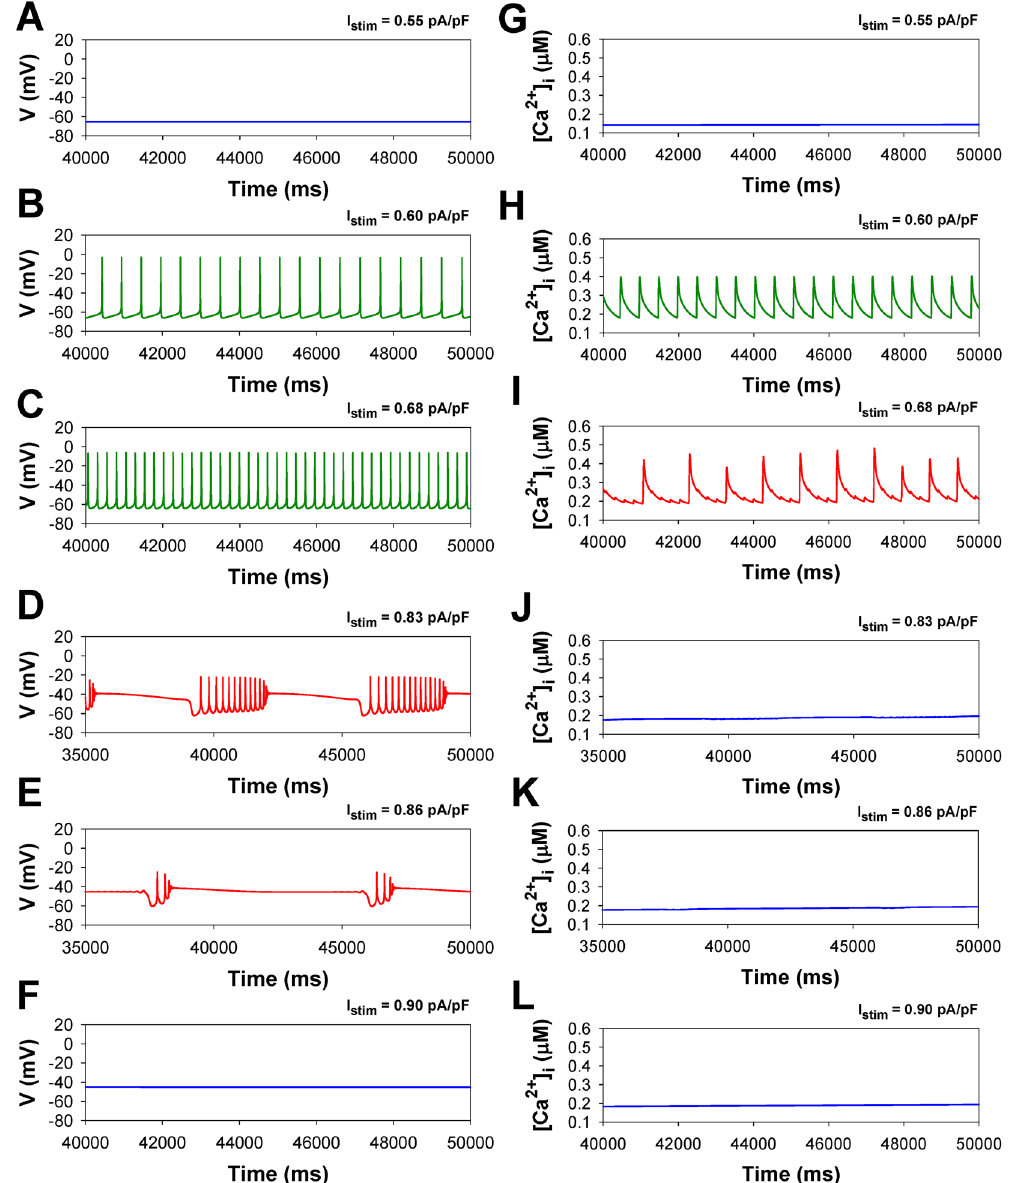
Figure 5. Simulated time series of AP (Panels A–F) and [Ca 2 + ] i transients (Panels G–L) in characteristic points of bifurcation diagrams for WT mouse ventricular myocytes in Fig. 6 during injection of continuous current: I stim = 0.55 pA/pF (Panels A,G); I stim = 0.60 pA/pF (Panels B,H); I stim = 0.68 pA/pF (Panels C,I); I stim = 0.83 pA/pF (Panels D,J); I stim = 0.86 pA/pF (Panels E,K); I stim = 0.90 pA/pF (Panels F,L). I Na with slow